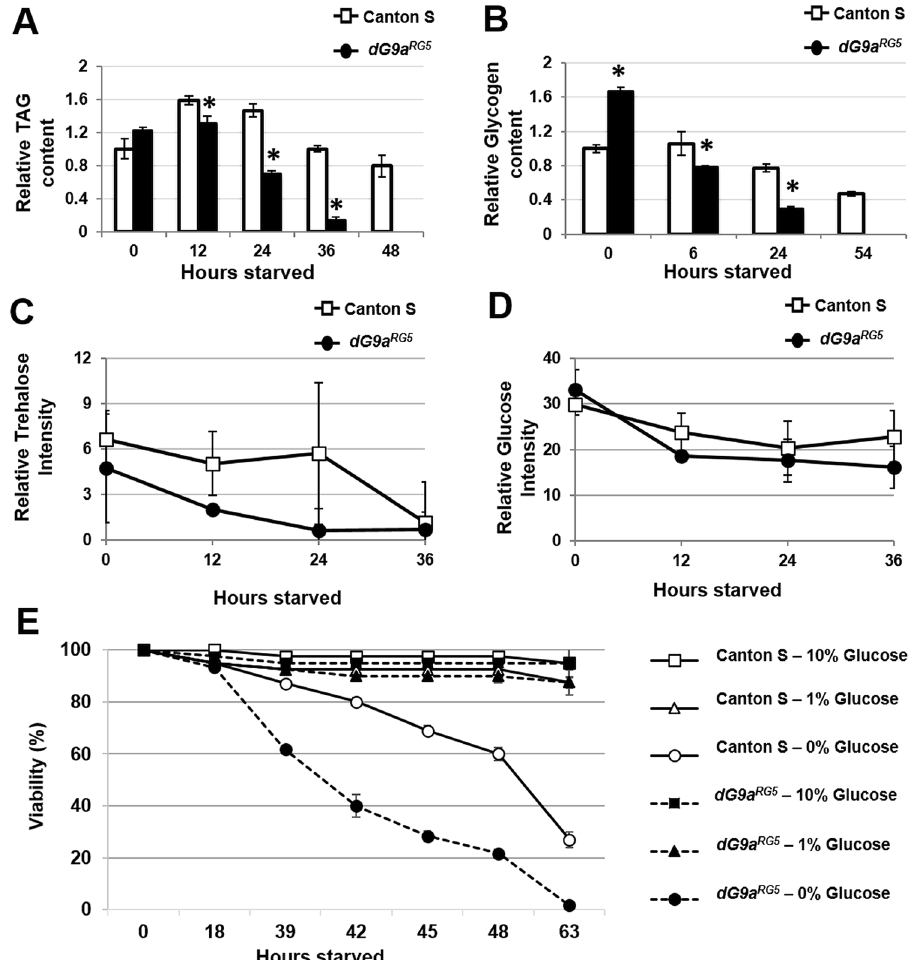
Figure 5. The loss of dG9a affects energy homeostasis in Drosophila during fasting. ( A ) Relative levels of TAG in the wild-type and dG9a RG5 mutant under starvation stress n = 3. * P < 0.05. ( B ) Relative levels of glycogen in the wild-type and dG9a RG5 mutant under starvation stress n = 5. * P < 0.05. The levels of trehalose ( C ) and glucose ( D ) from the GC-MS analysis. Only the level of trehalose showed a significantly different “genotype” between the wild-type and dG9a RG5 mutant in a two-way ANOVA with P = 9.17E-03. ( E ) The results of a viability assay with glucose supply (n = 40). When dG9a RG5 mutant flies were fed 1% and 10% glucose in PBS, they recovered their sensitivity and had similar viability to the